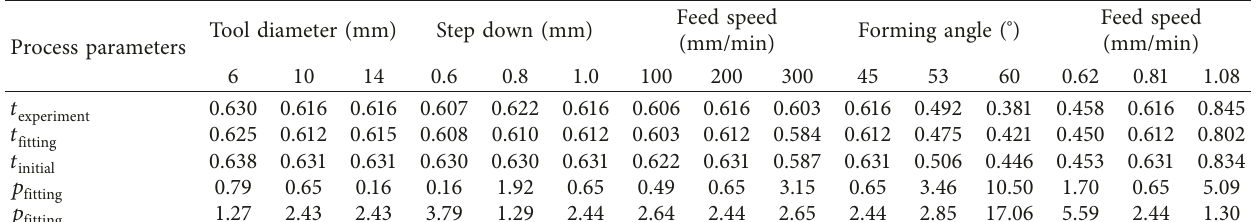
Table 5: Comparison between the theoretical and experimental results of the average thickness value. Tool diameter Process parameters